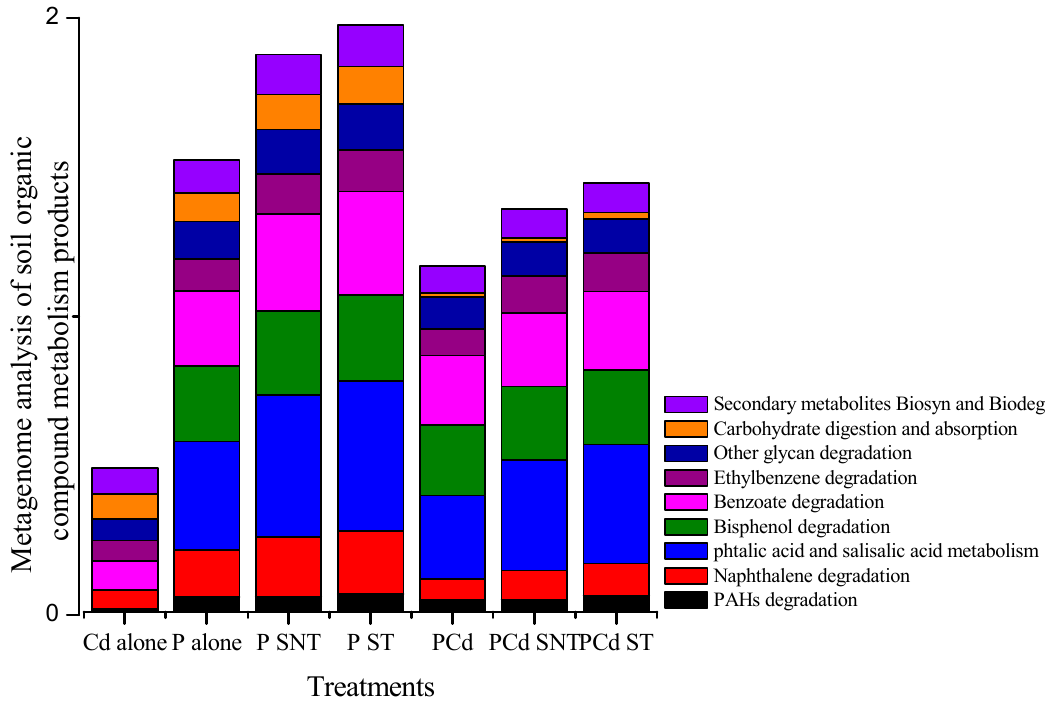
Figure 6. E ff ect of modified and unmodified rice straw on di ff erent genes involved in the metabolism Figure 6. Effect of modified and unmodified rice straw on different genes involved in the metabolism of organics materials identified in the di ff erent soil samples (in of organics materials identified in the different soil samples (in percentage).